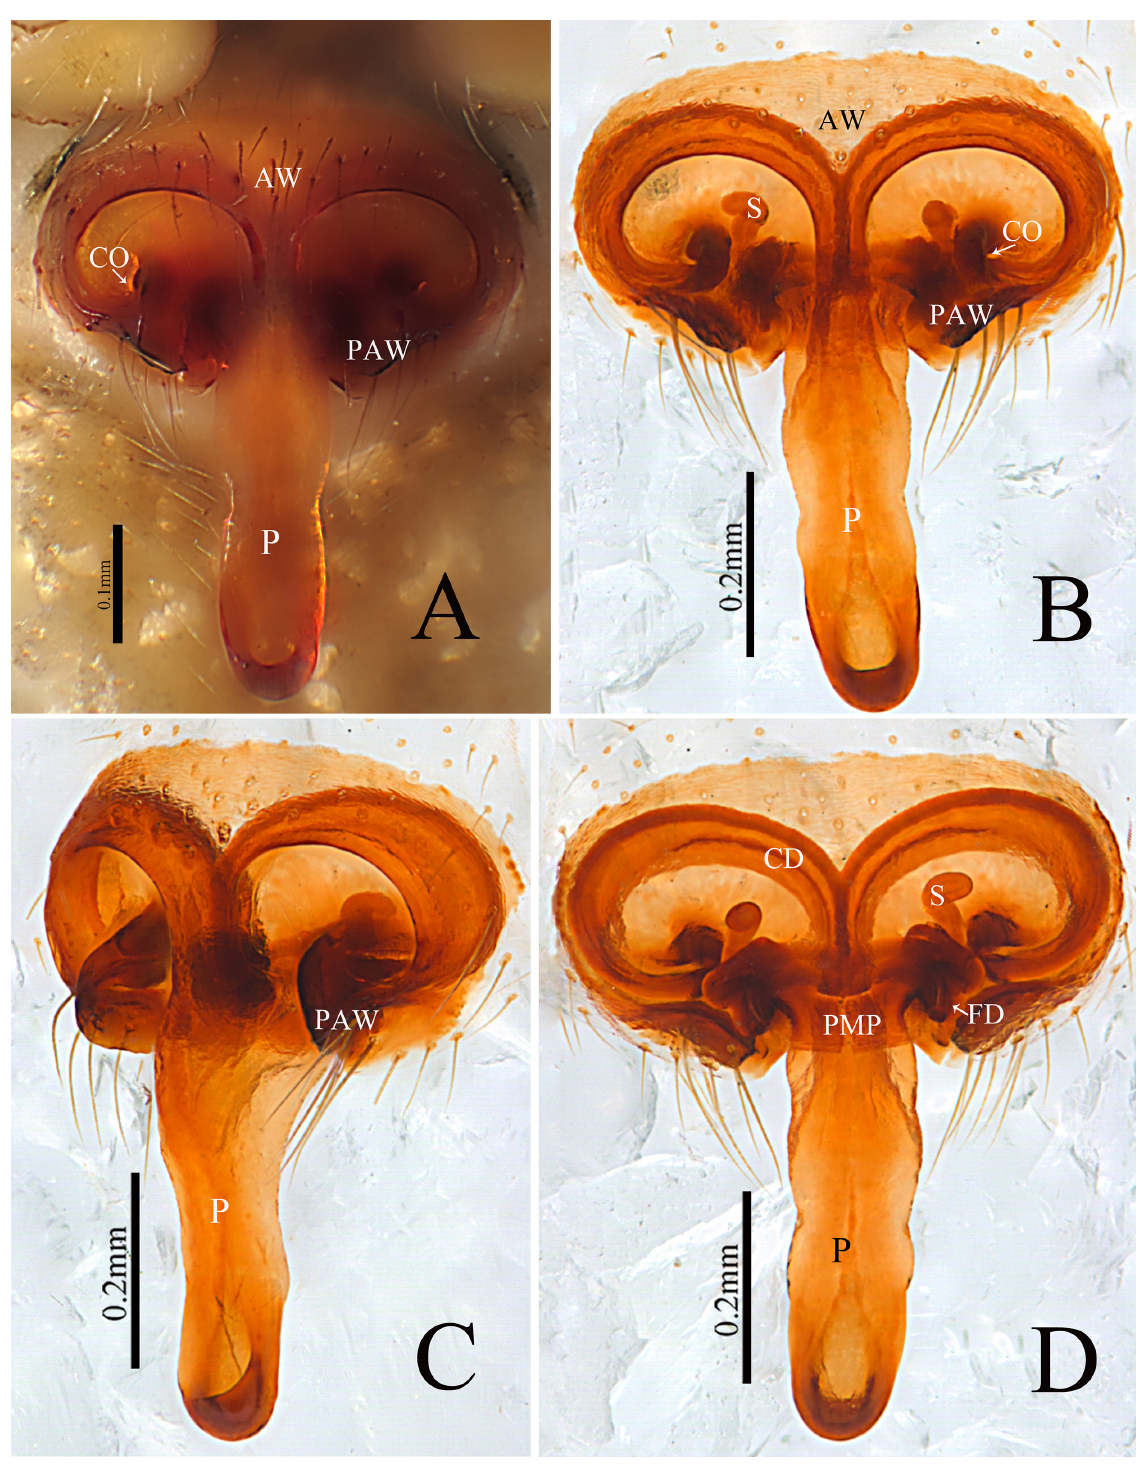
Fig. 27. Acroterius latus gen. et sp. nov., ♀, paratype (HNU-CGY123). A–B . Epigyne, ventral view. C . Epigyne, lateral view. D . Vulva,